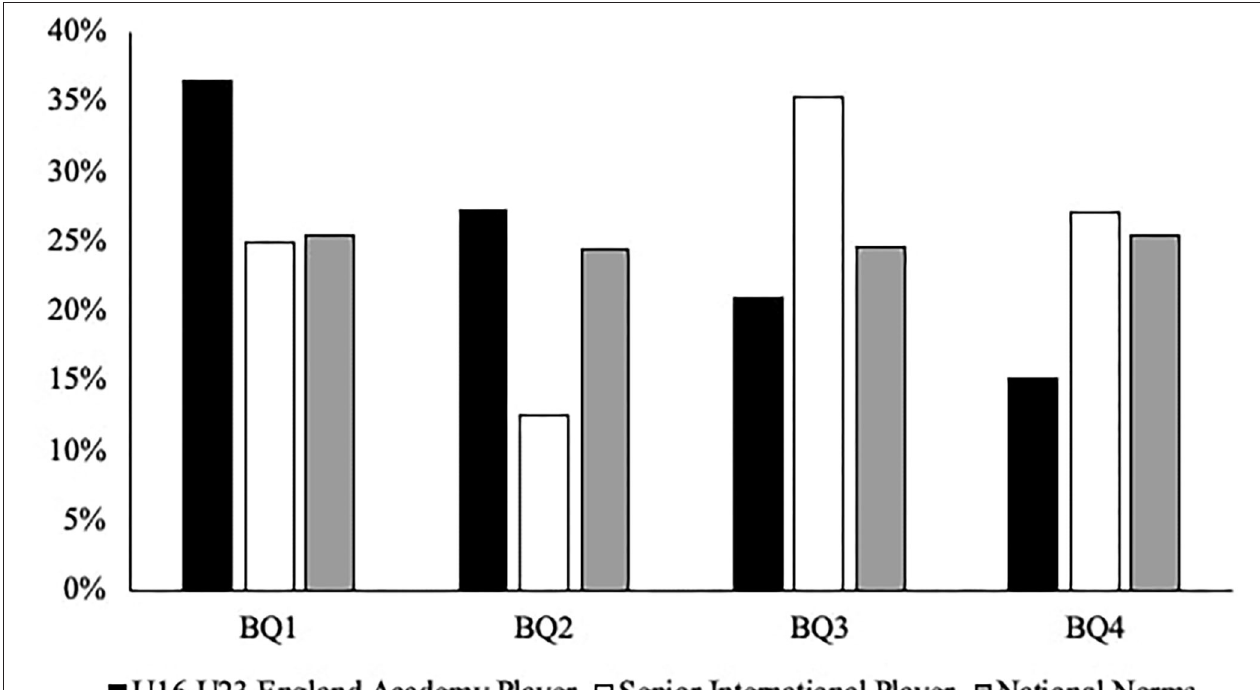
FIGURE 2 | The BQ distribution percentages of the international